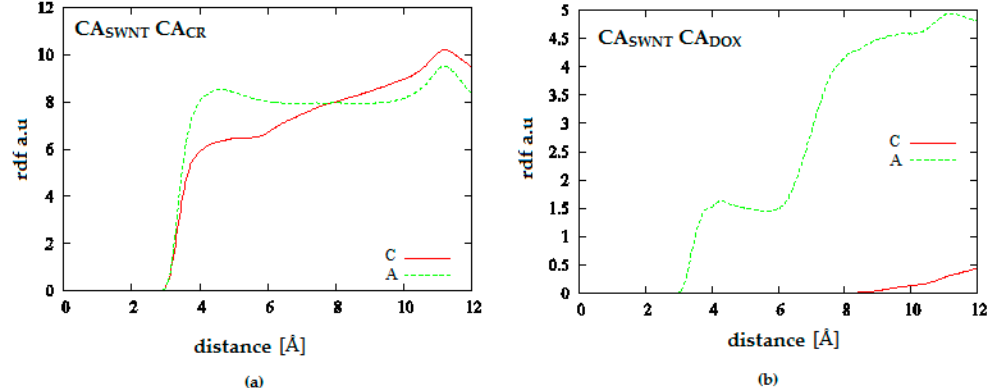
Figure 13. Radial distribution functions for the system SWNT (10.0) complexed with 50 molecules of CR and 20 molecules of DOX; ( a ) SWNT-CR interaction; ( b ) SWNT-DOX interaction; (A—neutral pH, C—acidic pH).